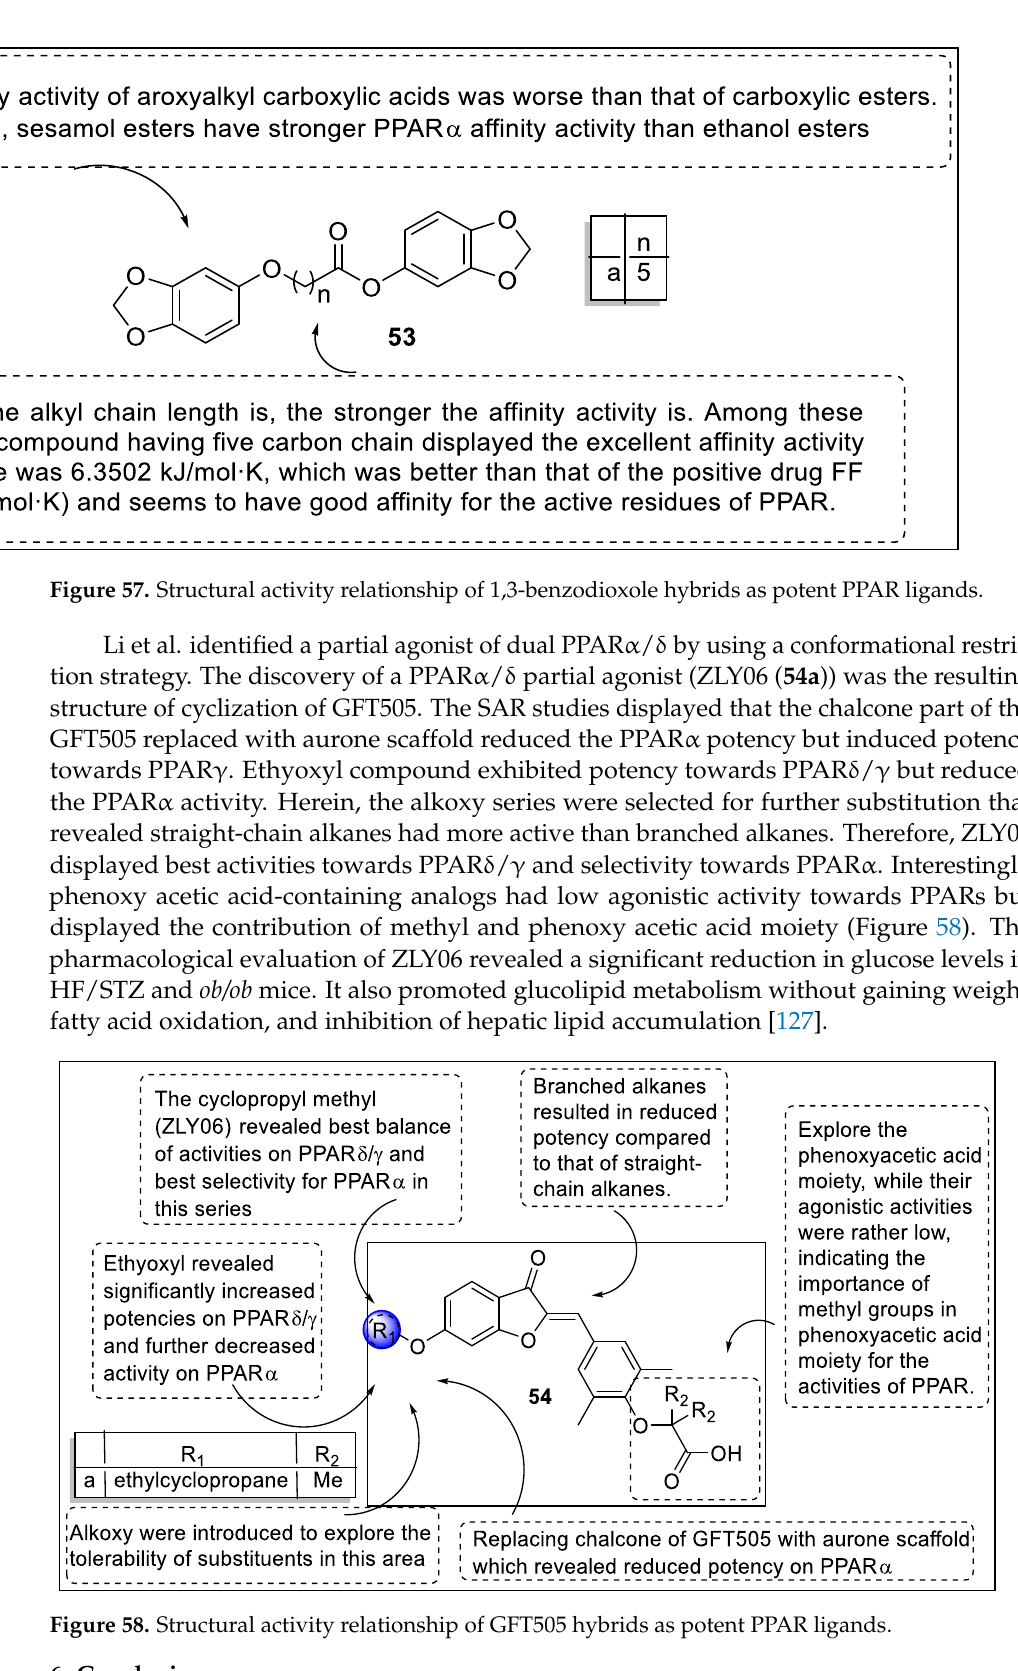
Figure 57. Structural activity relationship of 1,3-benzodioxole hybrids as potent PPAR ligands.